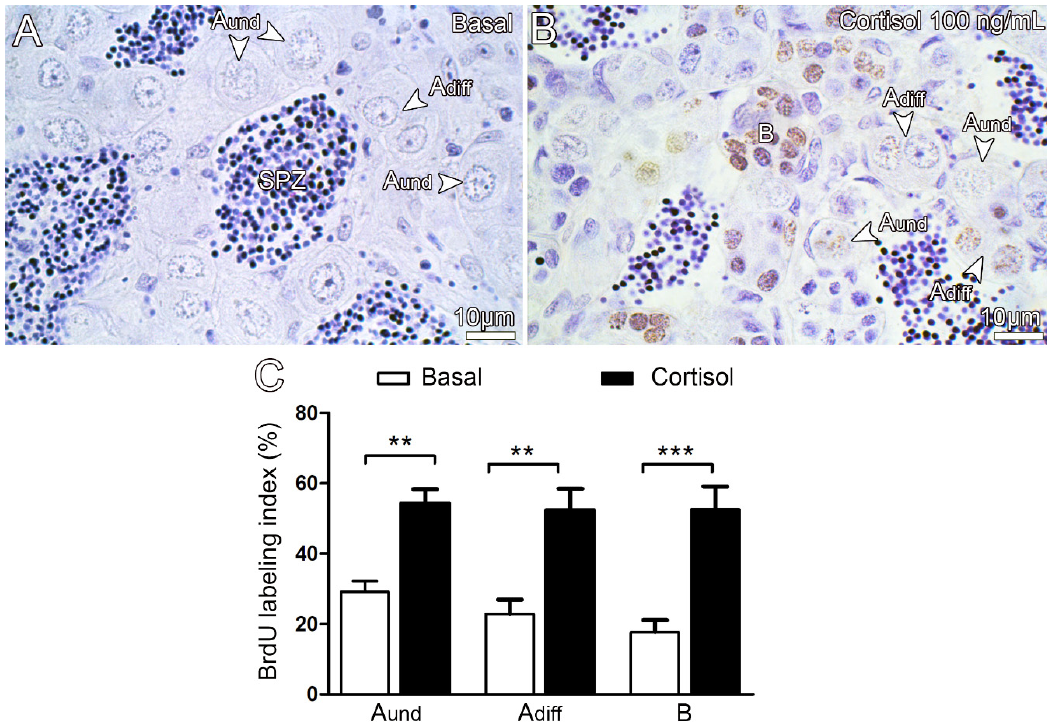
Figure 4. BrdU immunodetection from zebrafish testicular explants incubated for 7 days (long-term exposure) with 100 ng / mL cortisol compared with control (basal). ( A ) Basal. ( B ) Cortisol 100 ng / mL. Type A undi ff erentiated spermatogonia (A und ); type A di ff erentiated spermatogonia (A di ff ); type B spermatogonia (B) and spermatozoa (SPZ). ( C ) BrdU labeling index of A und , A di ff , and B in zebrafish testis treated in the absence (basal) or presence of cortisol (100 ng / mL) for 7 days of culture.